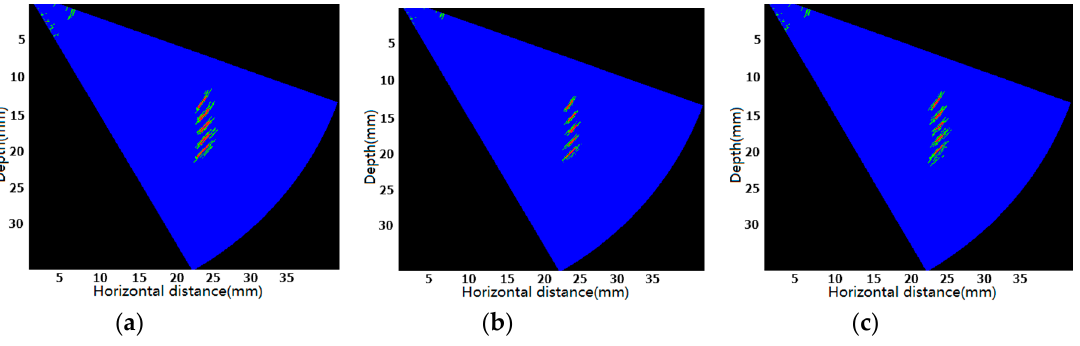
Figure 15. The results of ultrasonic phased array sector scan with different time delay accuracies: ( a ) 2 ns (4× interpolation CIC filter); ( b ) 1 ns (8× interpolation CIC filter); ( c ) 1 ns (8× interpolation half-band filter).